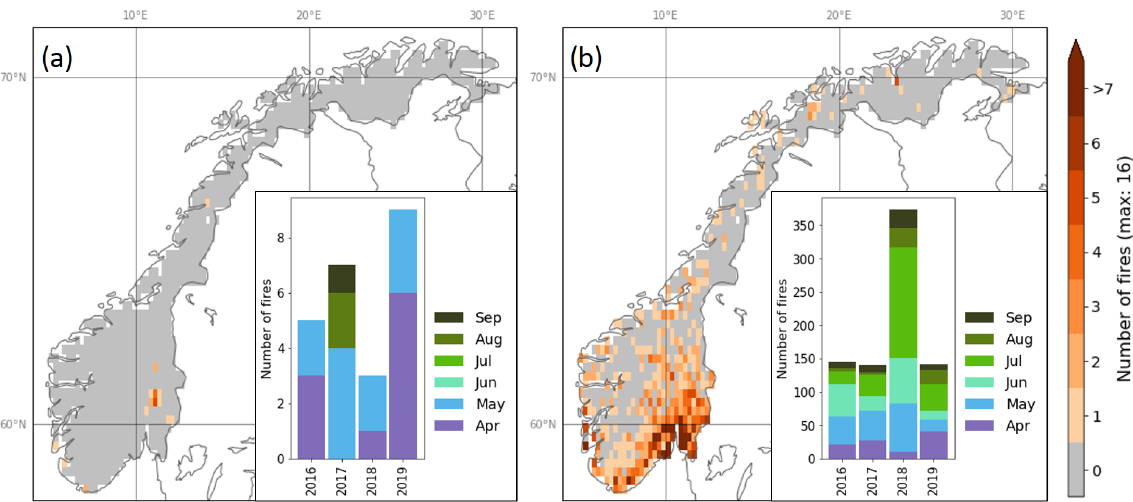
Figure 3. Distribution of fire occurrences in Norway using (a) the satellite-based dataset and (b) the Norwegian dataset. The figures show the spatial distribution over Norway (map; 0.25 ◦ resolution) and the temporal distribution over the period 2016–2019 (bar plot), as defined by the spatial and temporal domain of the Norwegian fire occurrence dataset. Note the different y axes of the two bar